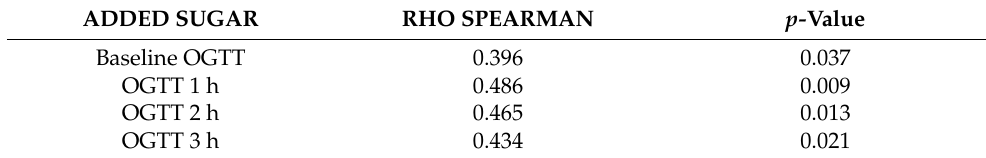
Table A9. Association between a high consumption of added sugars with glucose intolerance.